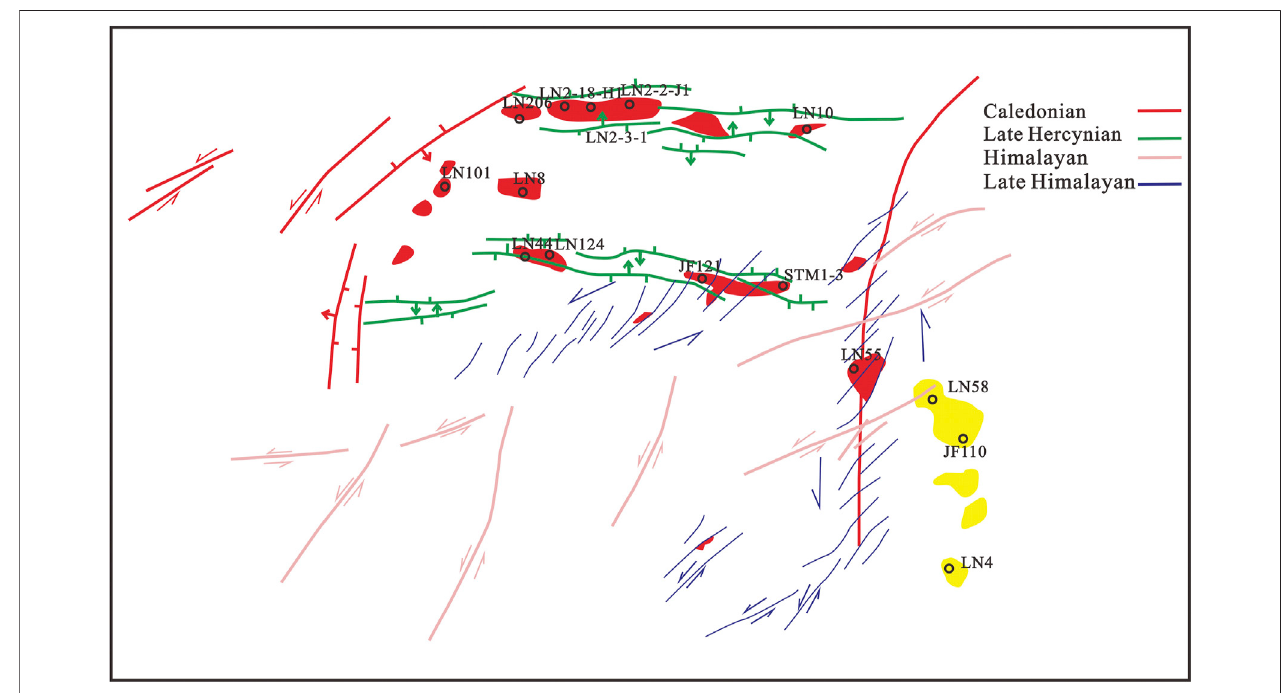
FIGURE 2 | Sketch of the fault system of the Triassic strata in the study area. The principal faults formed in different periods are highlighted by different colors. The wells marked in the fi gure are the selected sampling wells in this research.